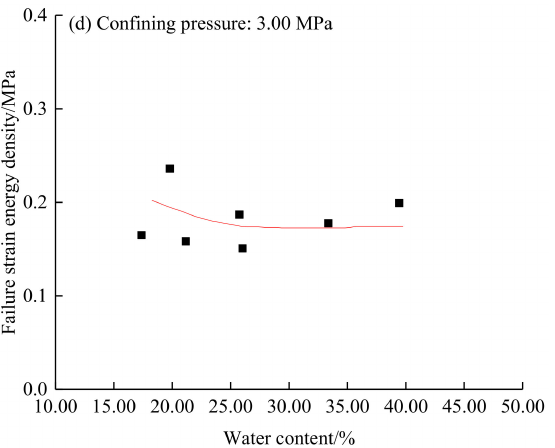
Figure 7. Failure strain energy density vs. water content (( a ) the confining pressure range: 0.05–0.50 MPa, ( b ) the confining pressure: 1.00 MPa, ( c ) the confining pressure: 2.00 MPa, ( d ) the confining pressure: 3.00 MPa; the black squares represent test data points, and the red lines are the change trend lines given according to the black